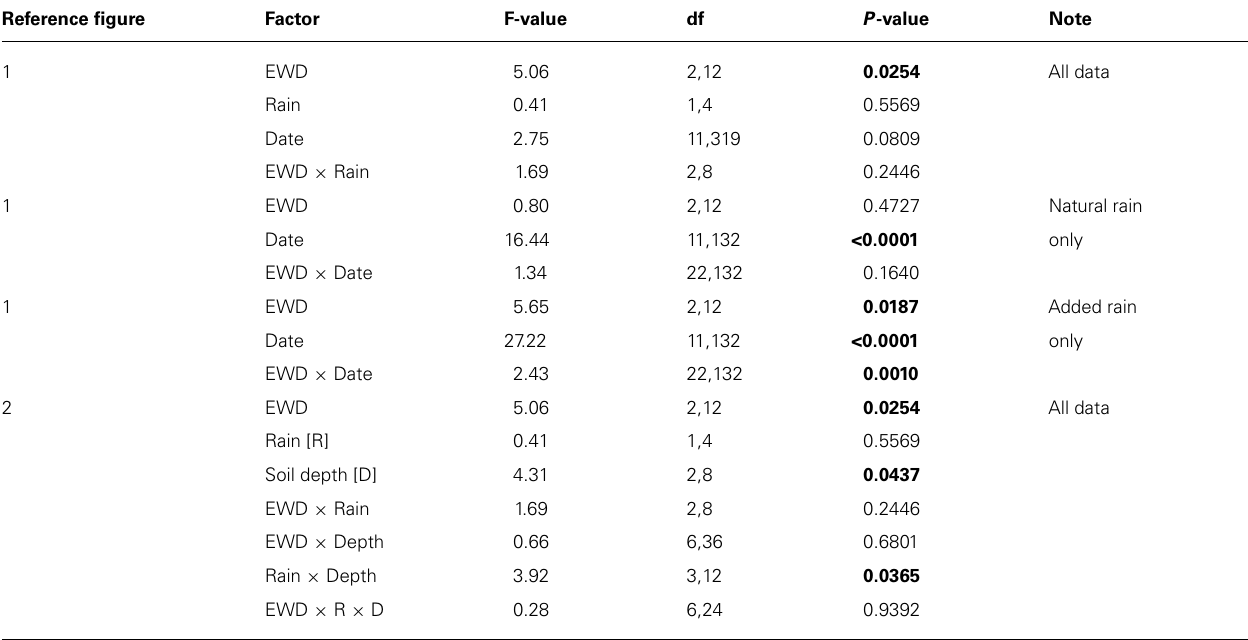
Table 1 | Results of analyses of variance (ANOVA) quantifying treatment effects of earthworm density (EWD) and additional simulated rainfall (Rain) on root length density (RLD) measured in the topsoil (0–20 cm) of 1 × 1 m experimental plots in native calcareous grassland in the Jura hills of northwestern